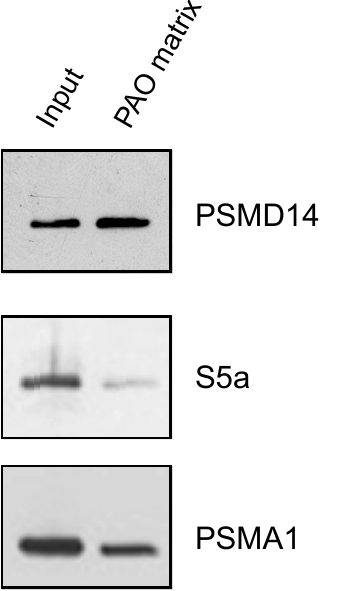
Figure 4. PSMD14 binding to PAO. Soluble proteasomes were incubated with PAO matrix, exten- sively washed and PSMD14, 19S (S5a), and 20S (PSMA1) content revealed by immunoblot.